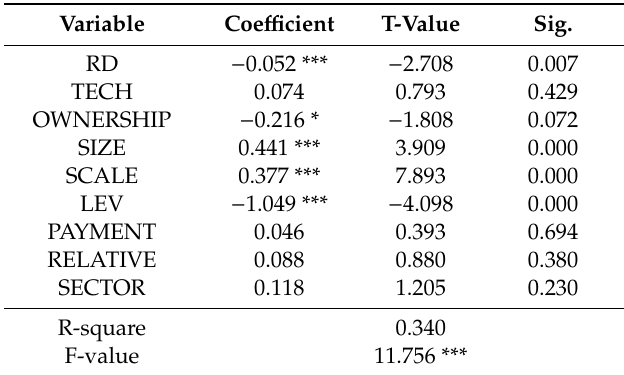
Table 5. Regression results of Model 1.